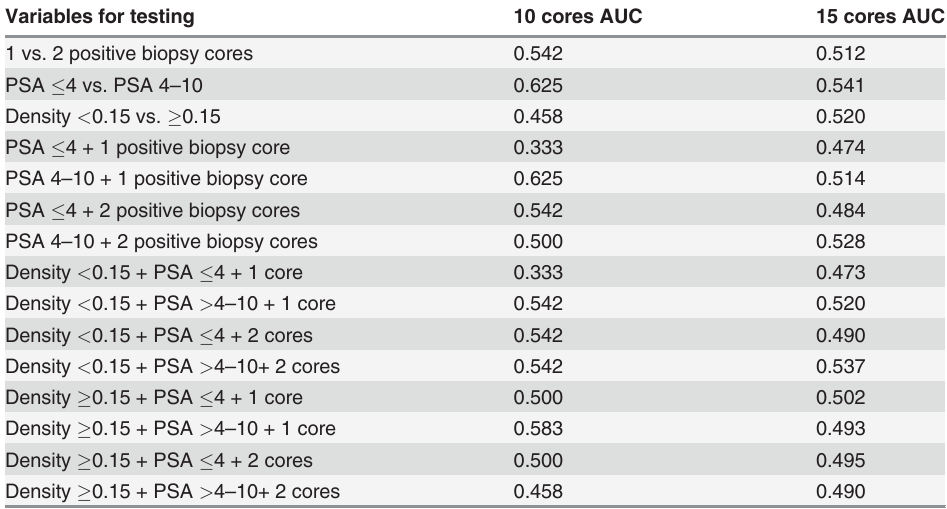
Table 11. Logistic regression for predicting PCa aggressiveness sub-analyzed 10 versus 15 biopsy cores; PSA (ng/ml), PSA density (ng/ml), Statistics: Logistic regression (AUC). Variables for